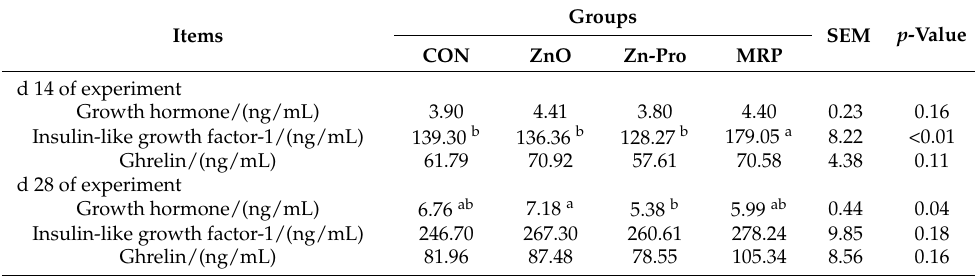
Table 4. Effects of different treatments on serum hormone levels of weaned